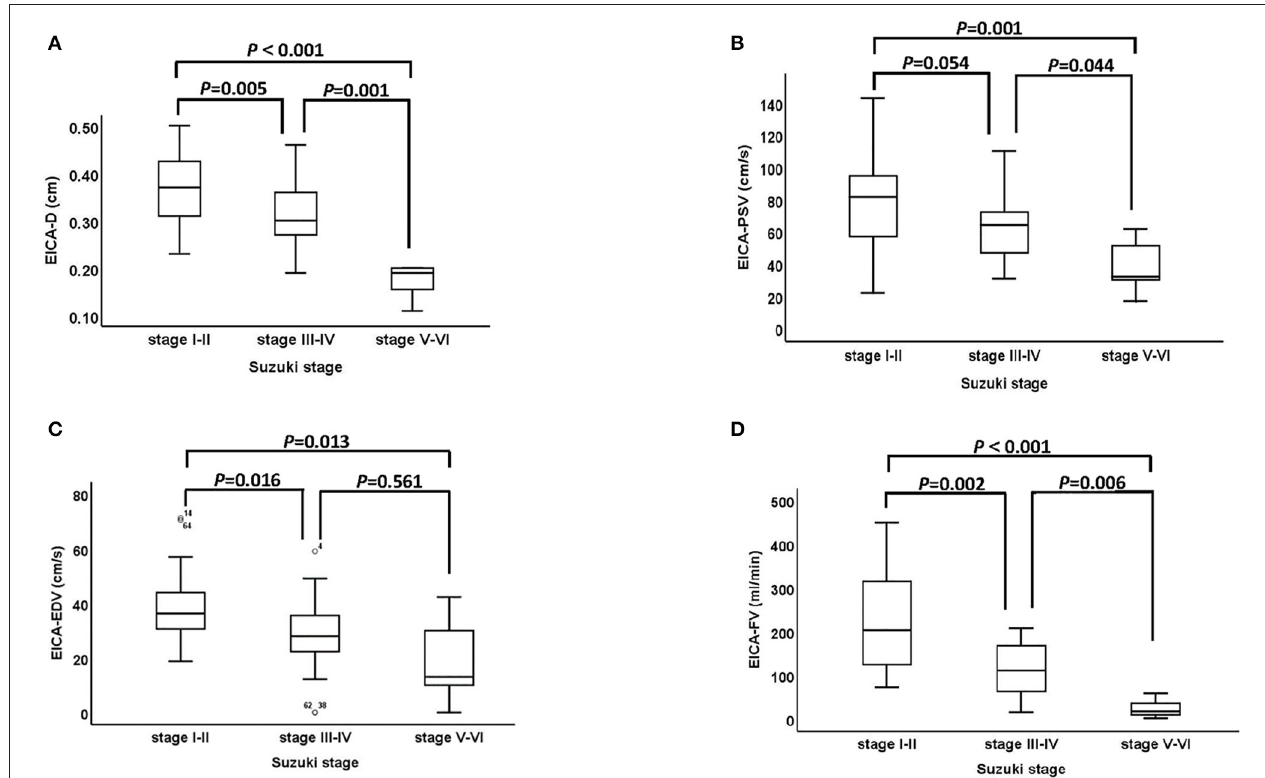
FIGURE 2 | The association between Suzuki stage and ultrasound parameters of the EICA. (A–D) The D, PSV, EDV, and FV of EICA between stage I-II, stage III-IV and stage V-VI groups were statistically significant (D: P < 0.001, PSV: P < 0.001, EDV: P < 0.001, FV: P < 0.001). EICA, extracranial internal carotid artery; D, diameter; PSV, peak systolic velocity; EDV, end diastolic velocity; FV, flow volume.